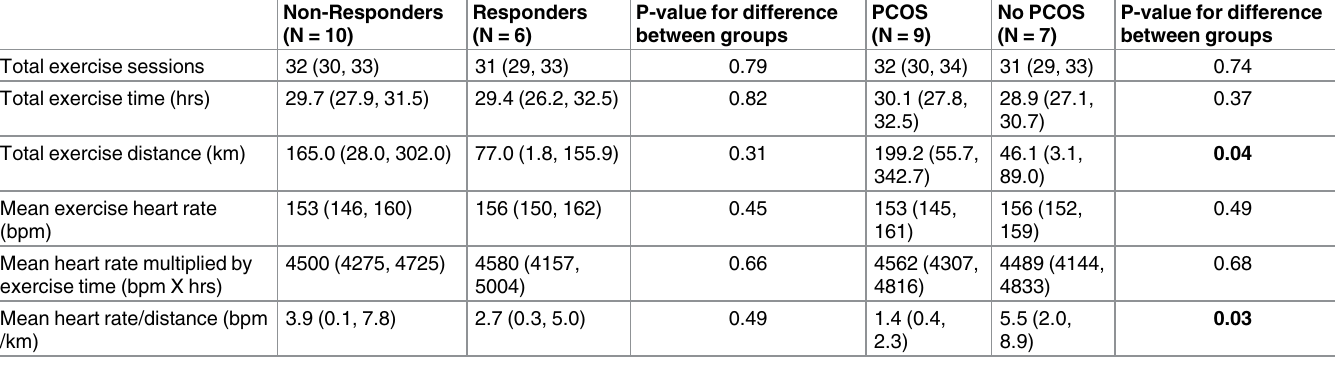
Table 2. Comparison of indicators of exerciseadherence and compliance during the 12-week exerciseintervention according to exerciserespon- sivenessand PCOS